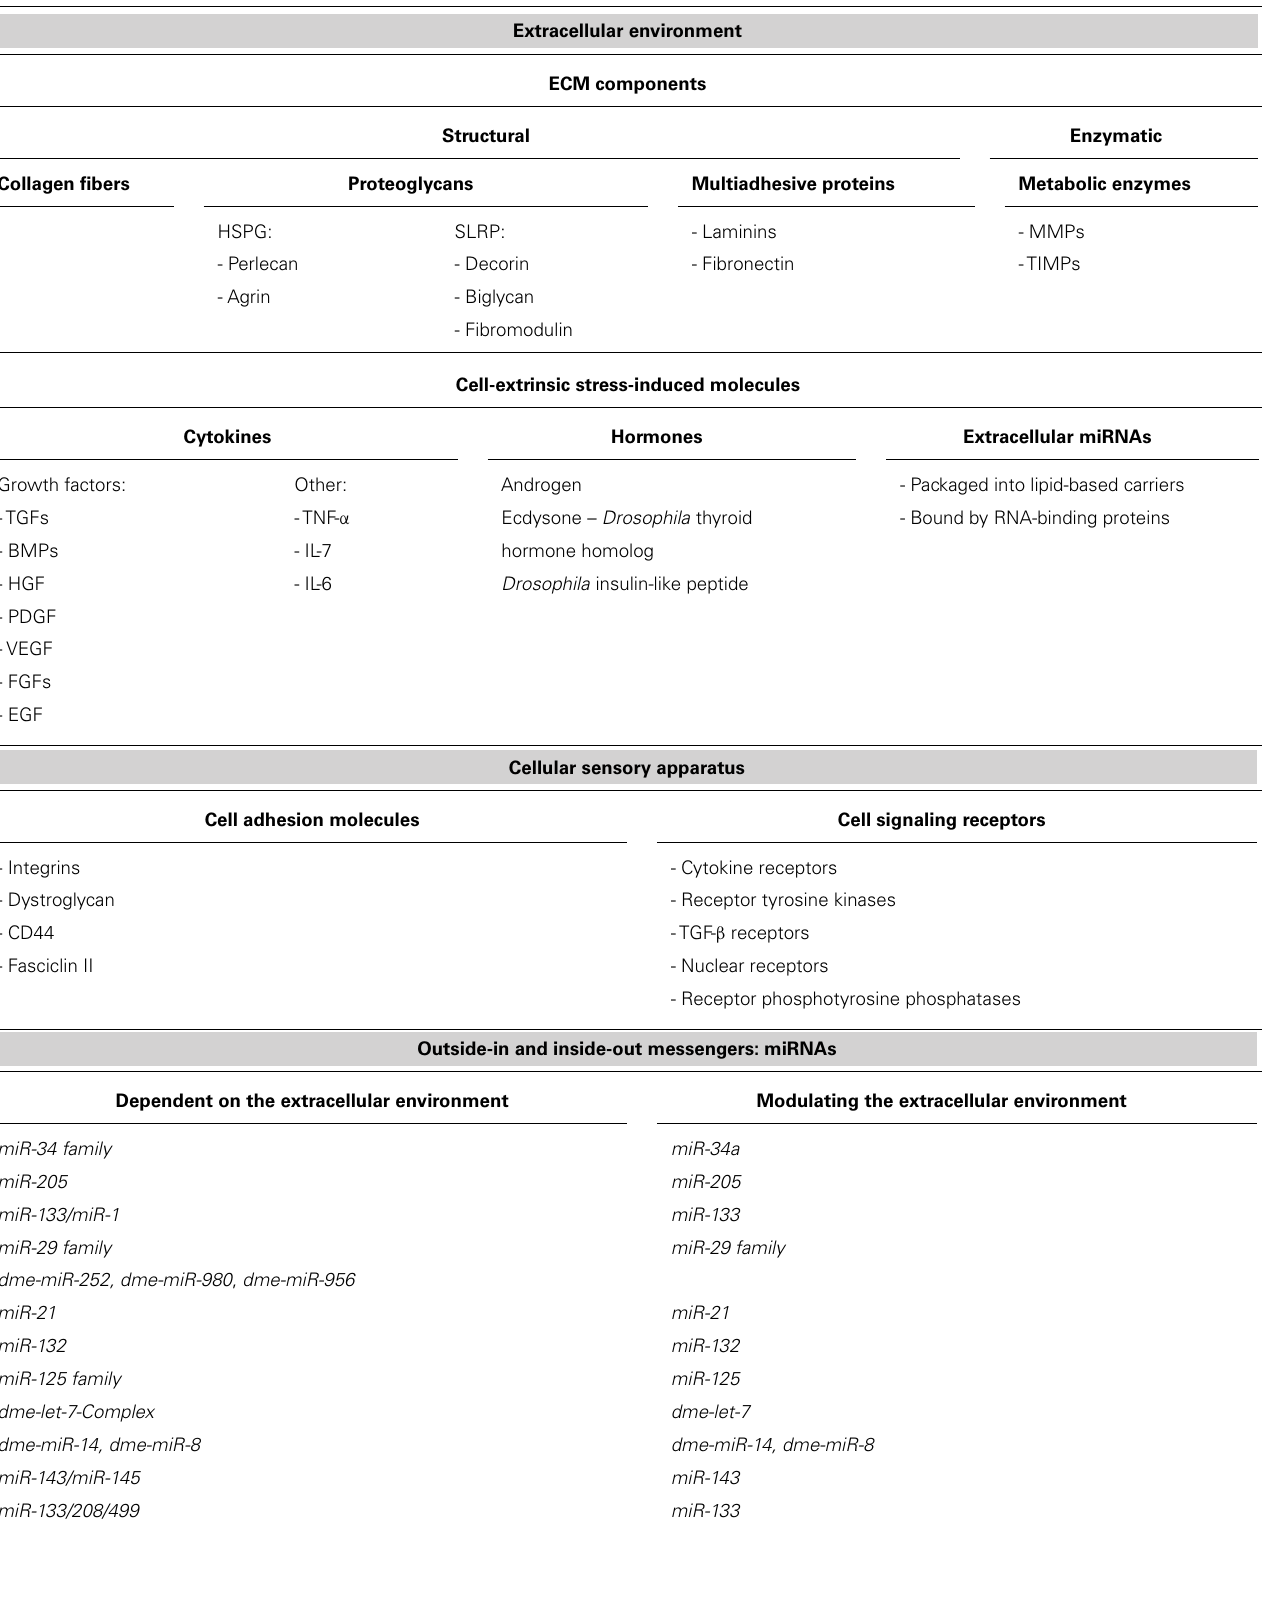
Table 1 |The components of the extracellular environment, cellular sensory apparatus, and miRNAs, mentioned in the